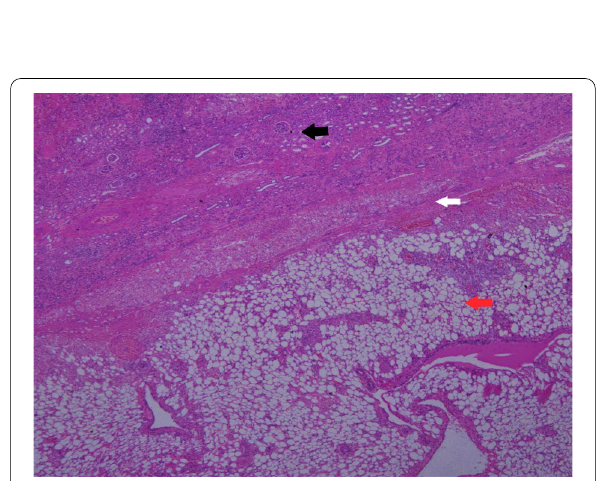
Fig. 10 AML (red arrow), normal renal parenchyma with glomerulus (black arrow), well circumscribed margin between AML and normal renal tissue (white